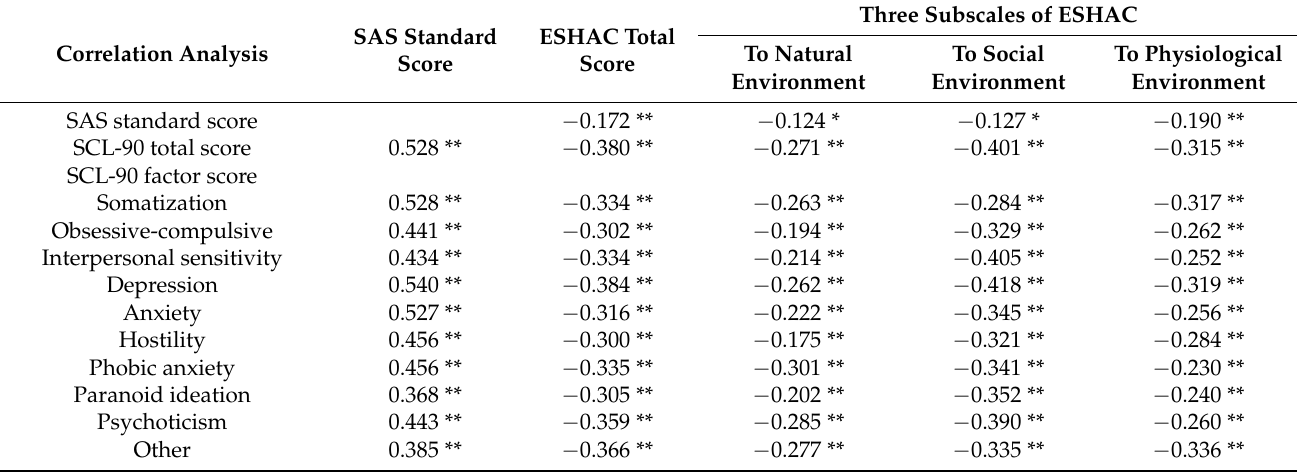
Table 5. Correlation between psychological and social fitness: Pearson analysis.